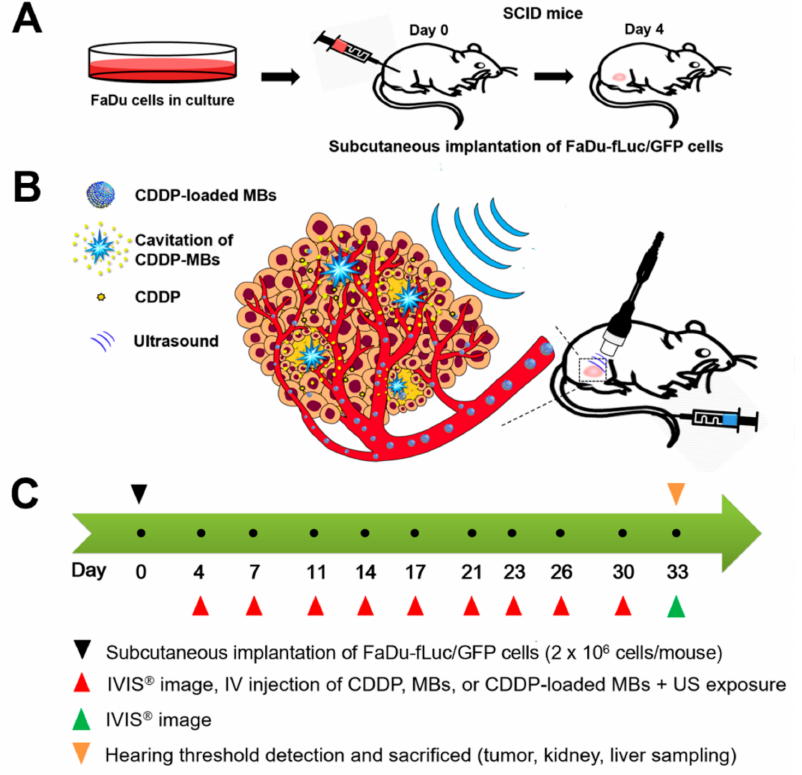
Figure 7. Scheme of animal study design. ( A ) SCID mice were subcutaneously implanted with FaDu-fLuc/GFP cells (2 × 10 6 cells/mouse) into the right flank region on day 0; ( B ) On day 4, tumor xenograft formation and size were determined by IVIS ® bioluminescence images (version 4.4,